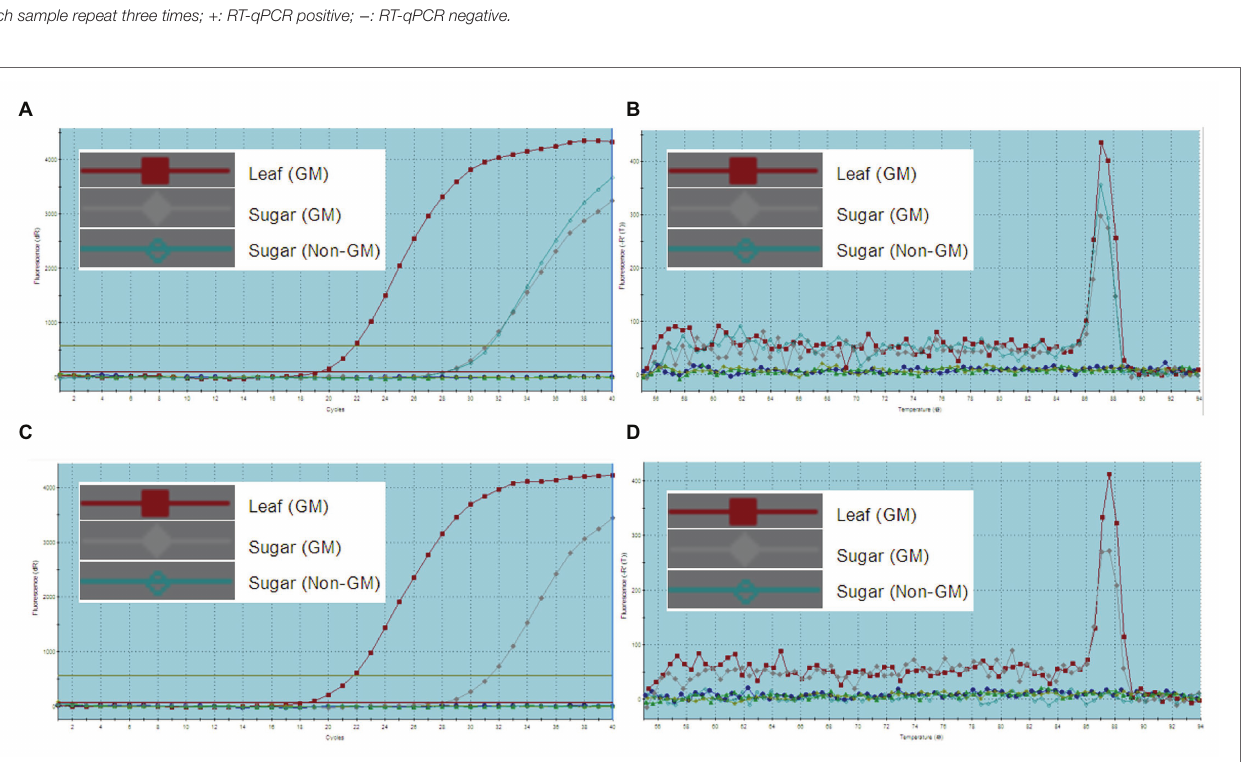
FIGURE 3 | RT-qPCR analysis of GM and non-GM sugar. (A) : amplification plots of endogenous gene actin (CT value: GM leaf, 22.12; GM sugar, 31.42; non-GM sugar, 31.17); (B) : dissociation curve of endogenous gene actin , the three samples share the same dissociation curve; (C) : amplification plots of the endogenous gene Cry1Ab (CT value: GM leaf, 21.81; GM sugar, 31.44; non-GM sugar, no CT value); (D) : dissociation curve of the endogenous gene Cry1Ab, GM leaf sample and GM sugar share the same dissociation curve, but the non-GM sugar has no dissociation